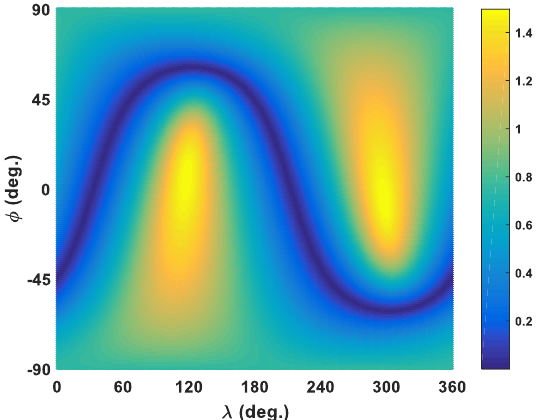
Figure 2. The absolute test statistic values of the No. 1 baseline by numerical traversal algorithm.